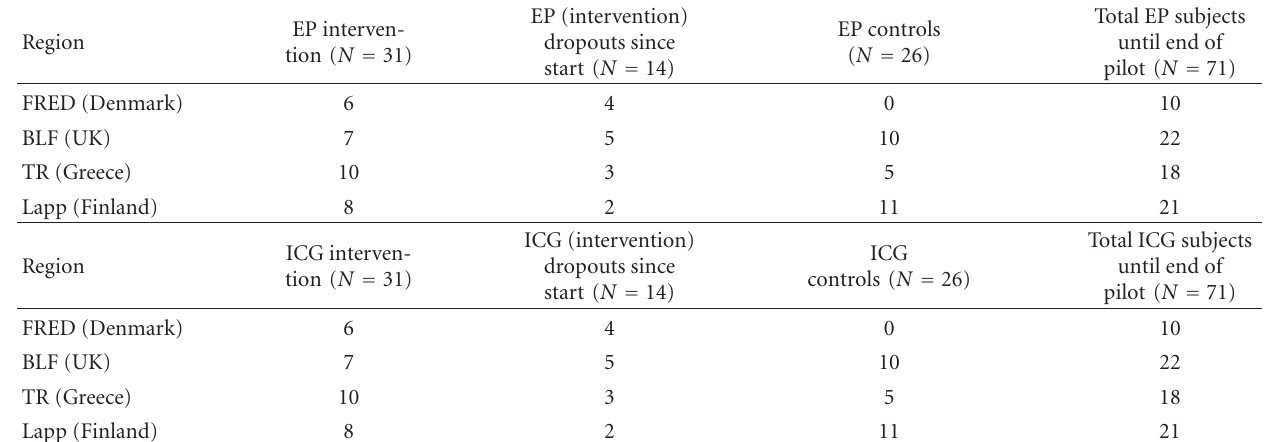
Table 3: Number of subjects participated in ISISEMD-controlled study.